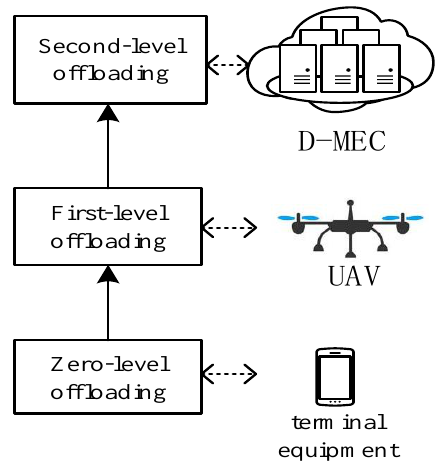
Figure 2. Multilevel offloading structure.